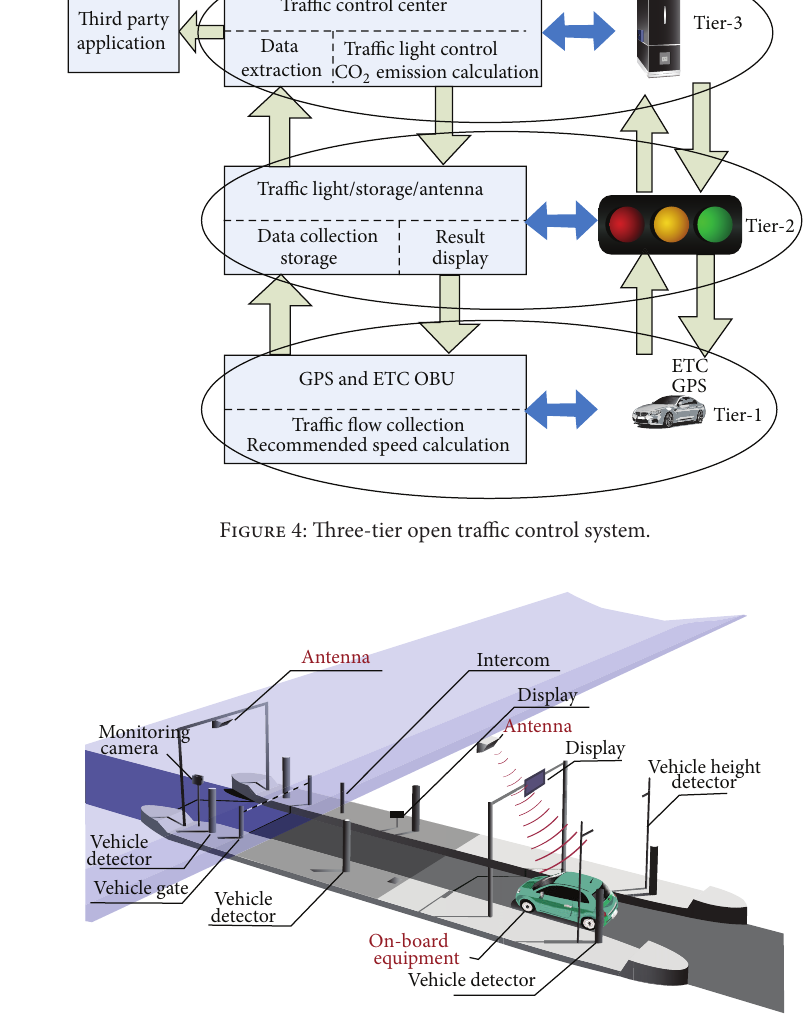
Figure 5: Electronic toll collection